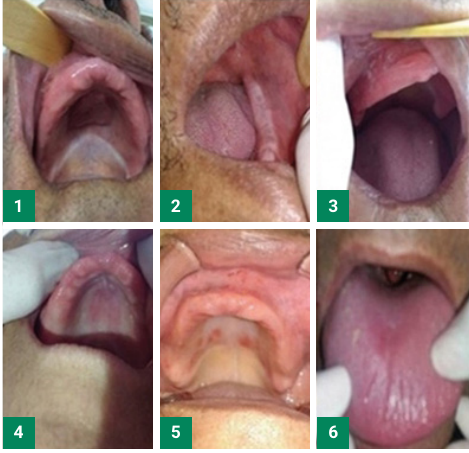
Figure 2. Horizontal sequence of images of the types of oral candidiasis found: Hiperplastic(1); Acute atrophic erythematous(2); Chronic multifocal Erythematous(3); Mucocutaneous(4); Erythematous (Prosthetic stomatitis)(5); Pseudomenbranous(6).